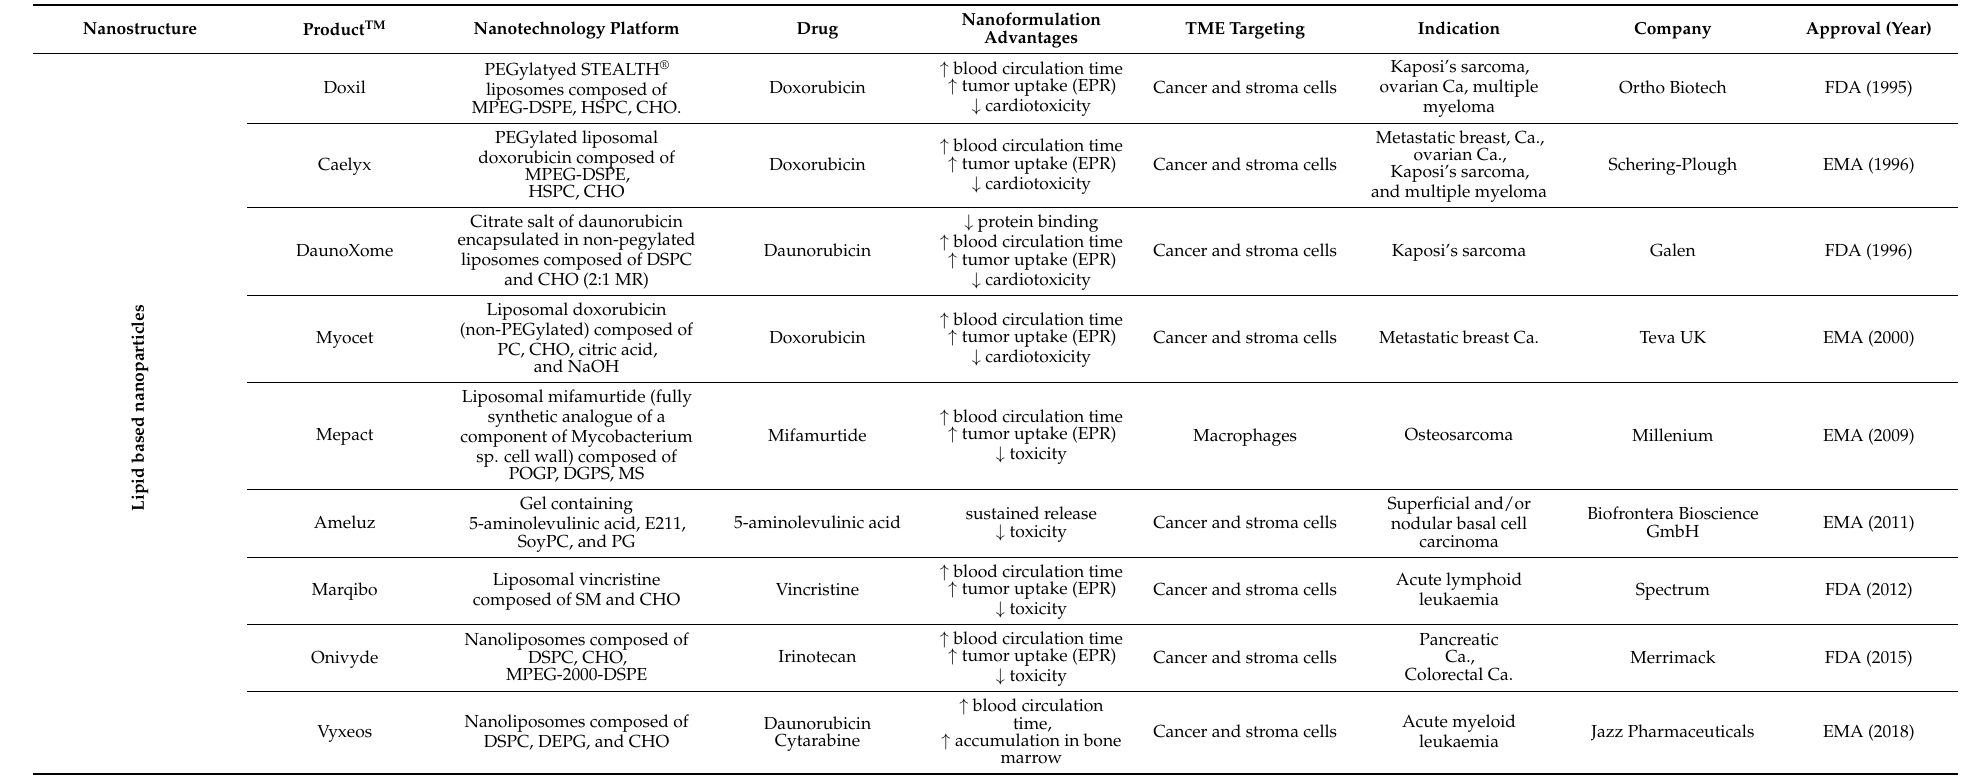
Table 1. Approved and marketed nanopharmaceuticals for cancer